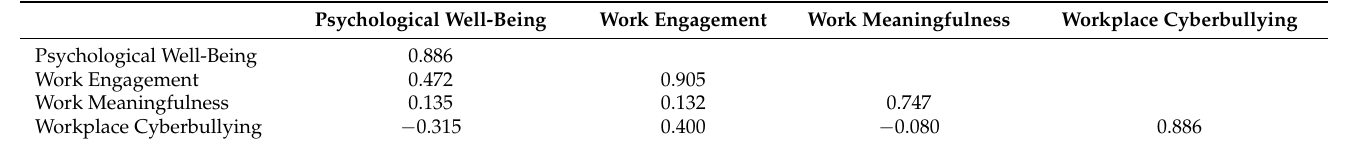
Table 2. Assessment of discriminant validity using Fornell–Larcker.